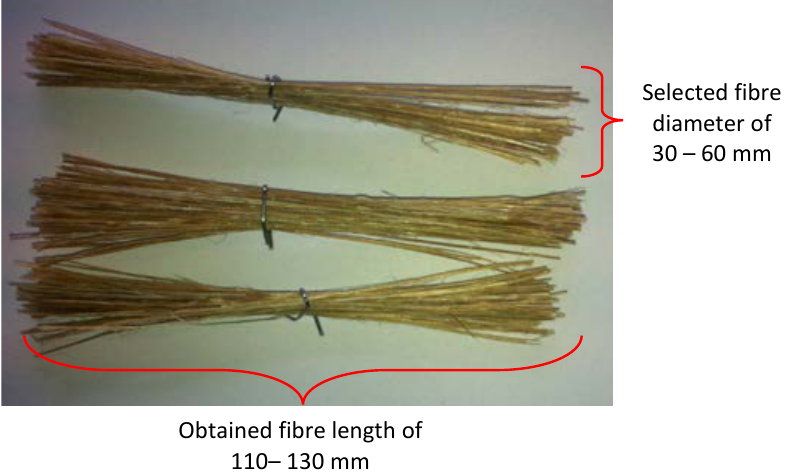
Figure 1. ( a ) Untreated and ( b ) treated fibre strips.